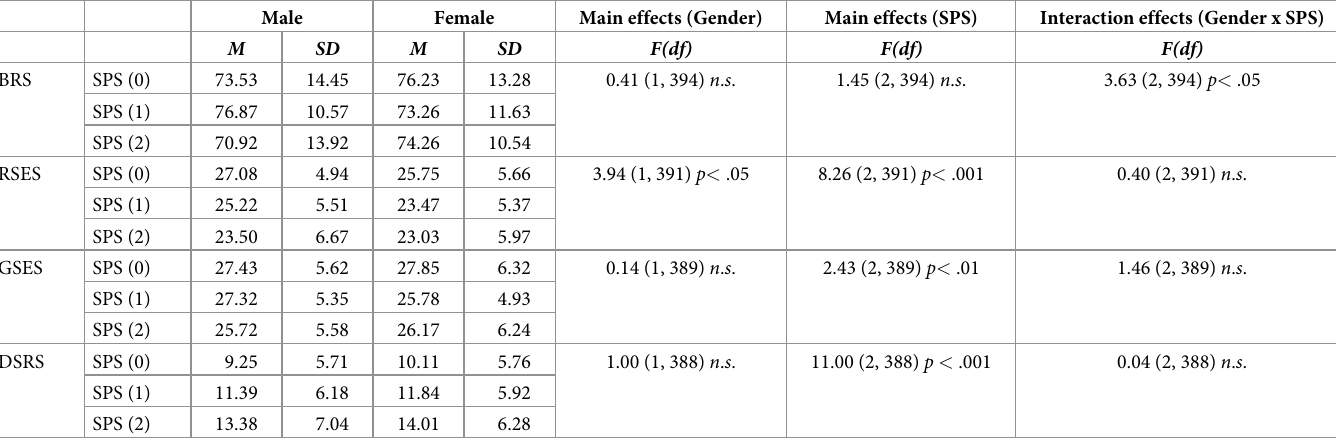
Table 4. Baseline differences for main variables by gender, SPS, and interactions. Male Female